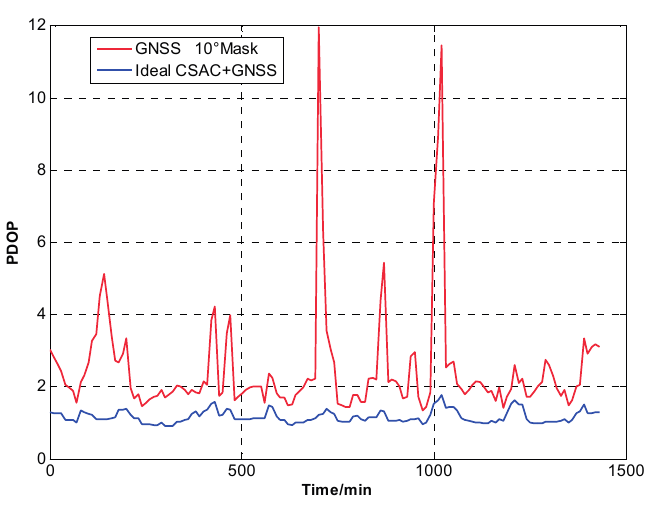
Figure 7. VDOP comparison at 5° cutoff.